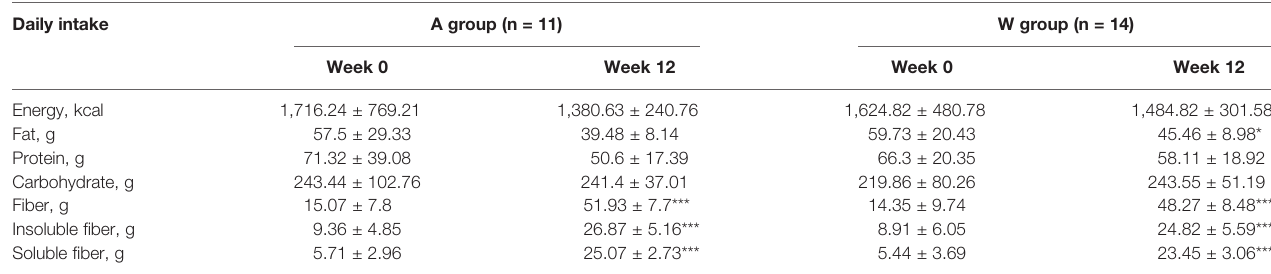
TABLE 1 | Daily energy and macronutrient intake of PCOS before and during the intervention. Daily